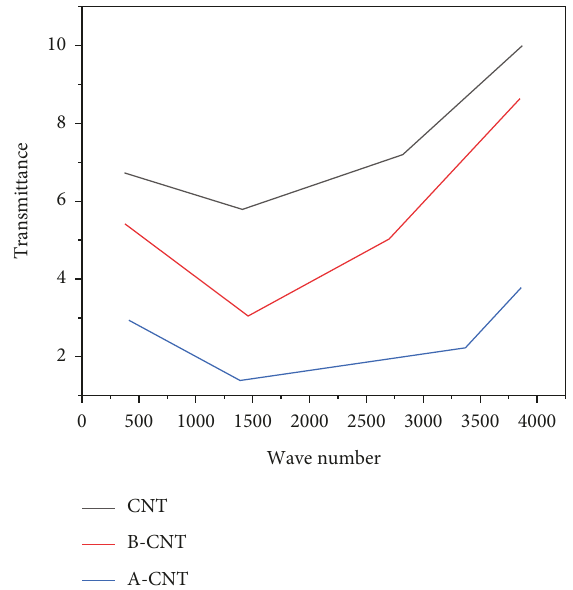
Figure 3: Infrared spectra of CNT, A-CNT, and